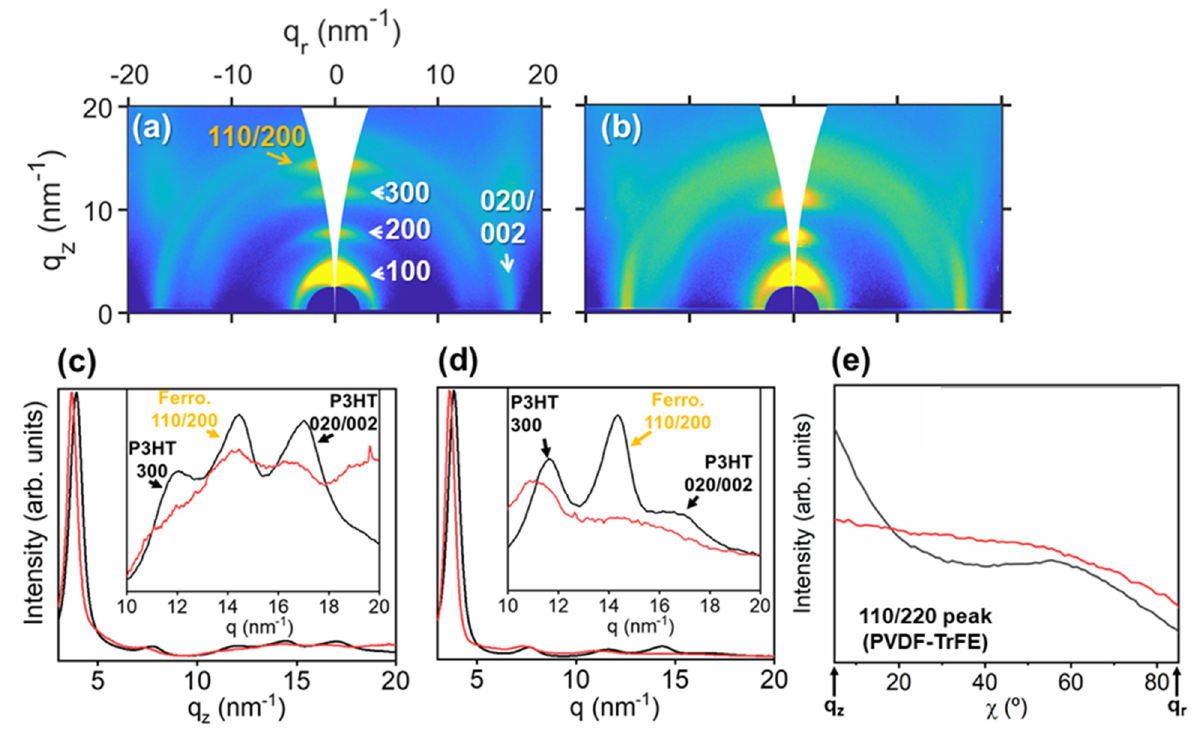
Figure 8. GIWAXS patterns of ( a ) a bilayer of P3HT and P(VDF-TrFE) non-irradiated, and ( b ) bilayer irradiated with two orthogonal polarizations at 532 nm (3500 + 100 pulses). In the right half of ( a ), reflections from P3HT are labeled, and in the left half, the P(VDF-TrFE) reflection is labeled. ( c ) Integration along the q z axis of the non-irradiated bilayer (black curve) and irradiated bilayer (red curve). ( d ) Integration along the whole azimuthal range of the non-irradiated bilayer (black curve) and irradiated bilayer (red curve). Insets in ( c , d ) are magnifications of the q-range, where the reflection from P(VDF-TrFE) appears. Reflections from P3HT and P(VDF-TrFE) (ferro.) are labeled in black and orange, respectively. Intensity of GIWAXS patterns in logarithmic scale. ( e ) Radial integration of GIWAXS patterns in the q-range to delimit the 110/200 reflection of P(VDF-TrFE).